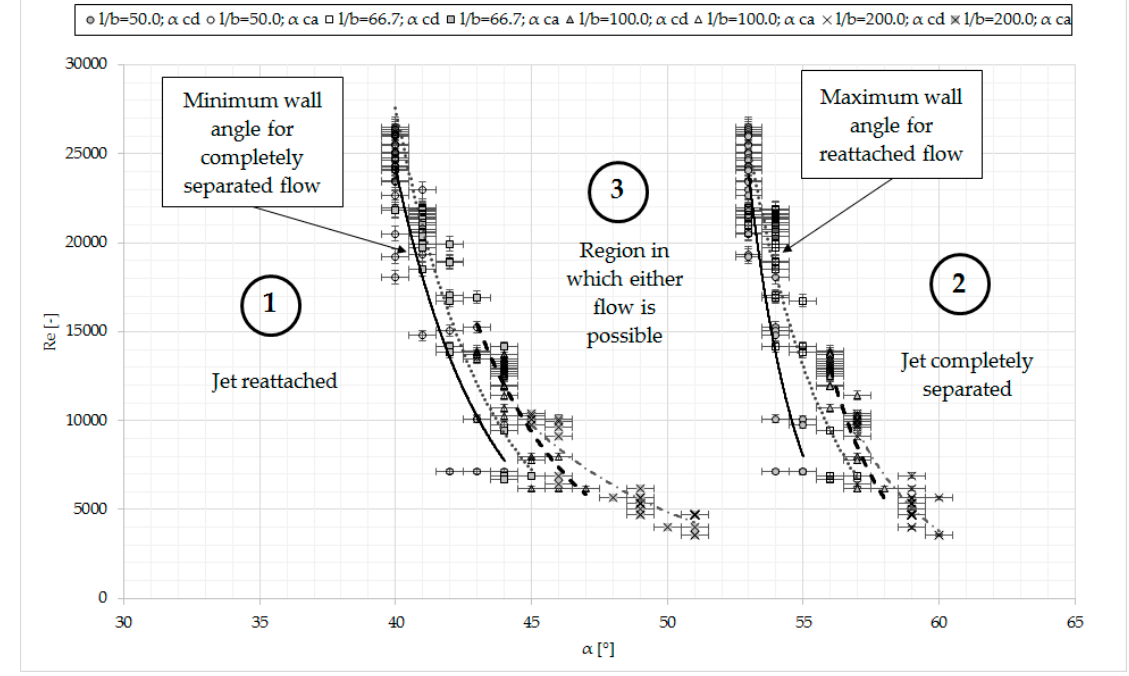
Figure 1. Region of Coanda effect hysteresis (CEH) determined experimentally based on the critical angles of jet separation ( α cd ) and attachment ( α ca ) and the Reynolds